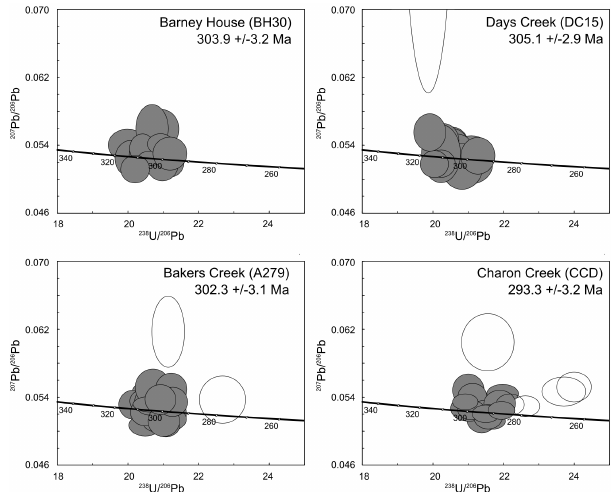
Figure 6. Tera–Wasserburg concordia plots of U-Pb data for Bakers Creek samples. Individual spot error ellipses are 68.3% confidence limits. Unfilled ellipses were not included in weighted mean age calculations; age intervals are 95% confidence and include error on